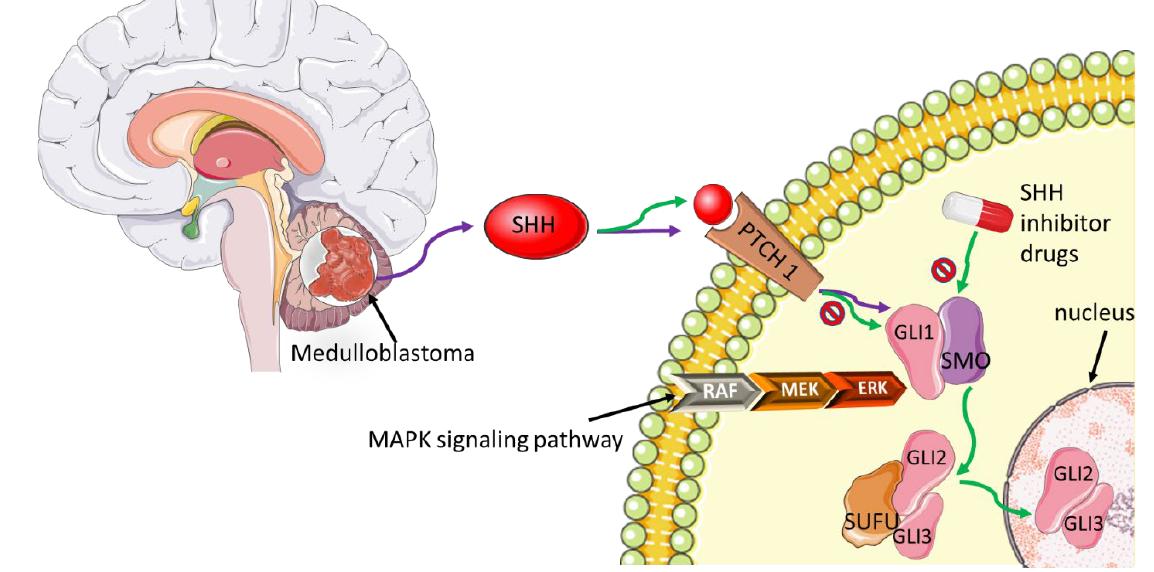
Figure 5. An overview of the SHH signaling pathway events in cancer. Efforts to block aberrant SHH signaling pathways induced by cancer cells which lead to downstream activation of SMO and cancer progression, have not been successful thus far. The mechanism of action by targeted inhibitory drugs such as vismodegib is through blocking the pathway at SMO. Multiple proteins associated with the SHH pathway and interrelated pathways (e.g., MAPK) could be targeted or used in a combinatorial therapeutic approach to decipher drug resistance to SMO inhibitors. - Inhibition.